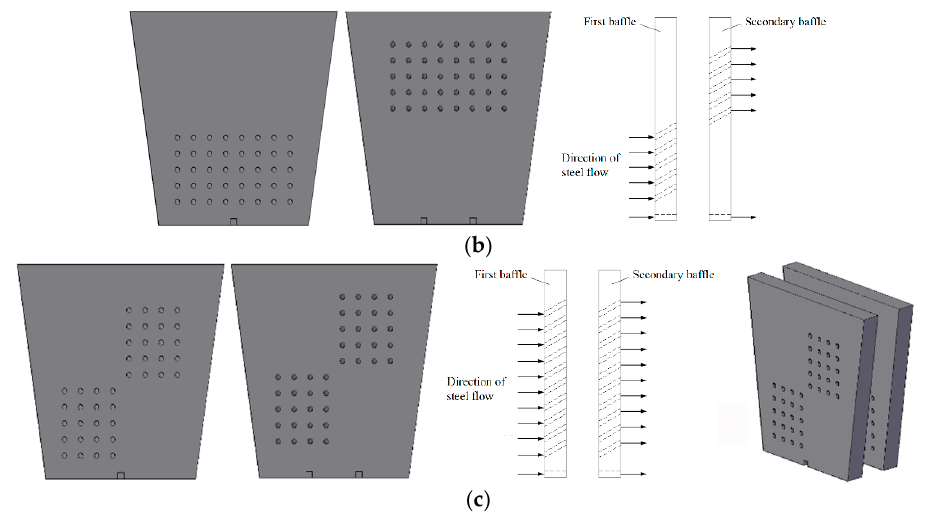
Figure 3. Hole array modes of MHDB. ( a ) UILO mode; ( b ) LIUO mode; ( c ) X mode.